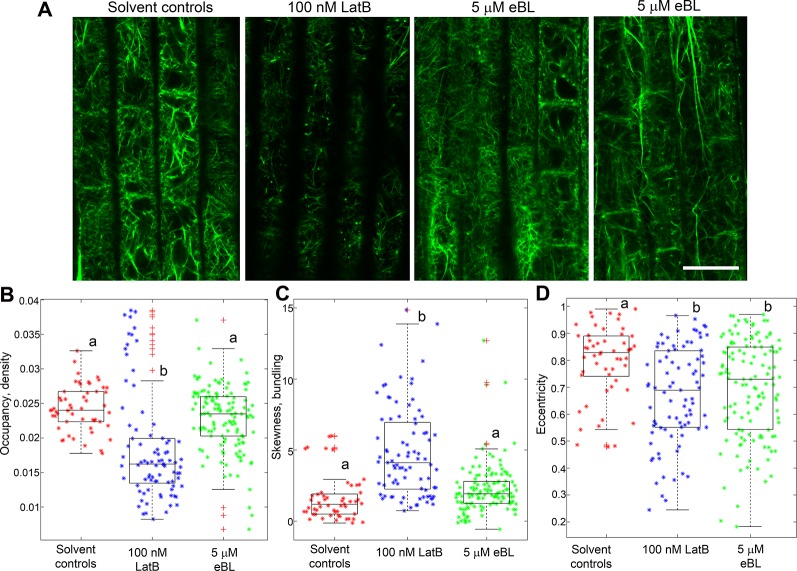
F-actin organization in epidermal cells of living M. truncatula roots expressing UBQ10:GFP-ABD2-GFP after 1 h exposure to LatB or eBL. (A) Representative single confocal optical section images of cells in the elongation zone. Note the reduced fluorescence and extensive fragmentation of F-actin in cells treated with LatB but not with eBL. The two right most panels show variable effects of eBL on F-actin organization. (B–D) Combined box and scatter plots showing quantitative analysis of F-actin occupancy (density), skewness (bundling) and eccentricity in root cells of the transition/elongation zone. Unlike LatB-treatment, no significant differences between eBL and solvent controls were detected with regard to F-actin occupancy (B) and skewness (C). However, a significant difference was observed between eBL and solvent controls with regard to the eccentricity metric, which refers to alignment of F-actin (D). Asterisks (*) refers to individual data points and + mark outliers. Statistical significance was determined by one-way ANOVA. Bars are means (n > 50 cells) ± S.E. Different letters indicate significant differences among means (P < 0.05, Tukey’s test). Scale bar = 20 μm.